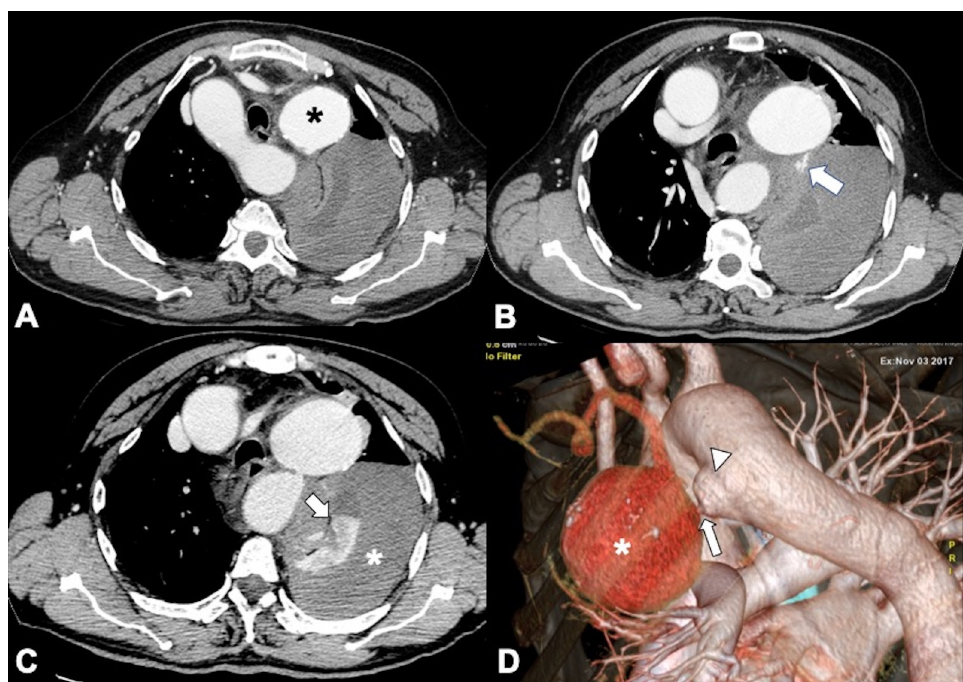
Figure 1. Computed tomography angiography (CTA) provides a rapid noninvasive diagnosis of the entire aorta including aberrant anatomy and pathology. ( A ) A 74-year-old man presenting in ED with 10 h of abrupt onset of acute chest pain, improving anemia, hypotension (blood pressure of 70/40 mm Hg in both upper extremities), and shortness of breath. CTA shows a right aortic arch and a pleural and extrapleural left hematoma from an aneurysm (asterisk) of a retroesophageal aberrant left subclavian artery (ALSA). ( B ) More caudal axial scan shows the ALSA aneurysm rupture site (arrow). Note the anomalous course of the left brachiocefalic vein posterior to the ascending aorta. ( C ) CTA-delayed phase shows contrast medium extravasation in the extrapleural hematoma (asterisk); note extrapleural fat sign (arrow). ( D ) 3D volume rendering oblique sagittal reformat image clearly shows the aneurysm (asterisk) coming immediately off the ALSA origin (arrow) from a Kommerell’s diverticulum (arrowhead). Table 2. Thoracic aorta anatomy: Imaging considerations and normal measurements.